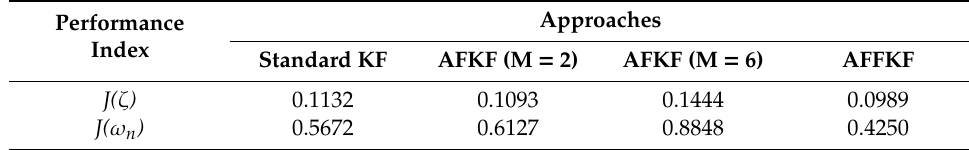
Table 2. Comparison of performance index for estimation of normal parameter.